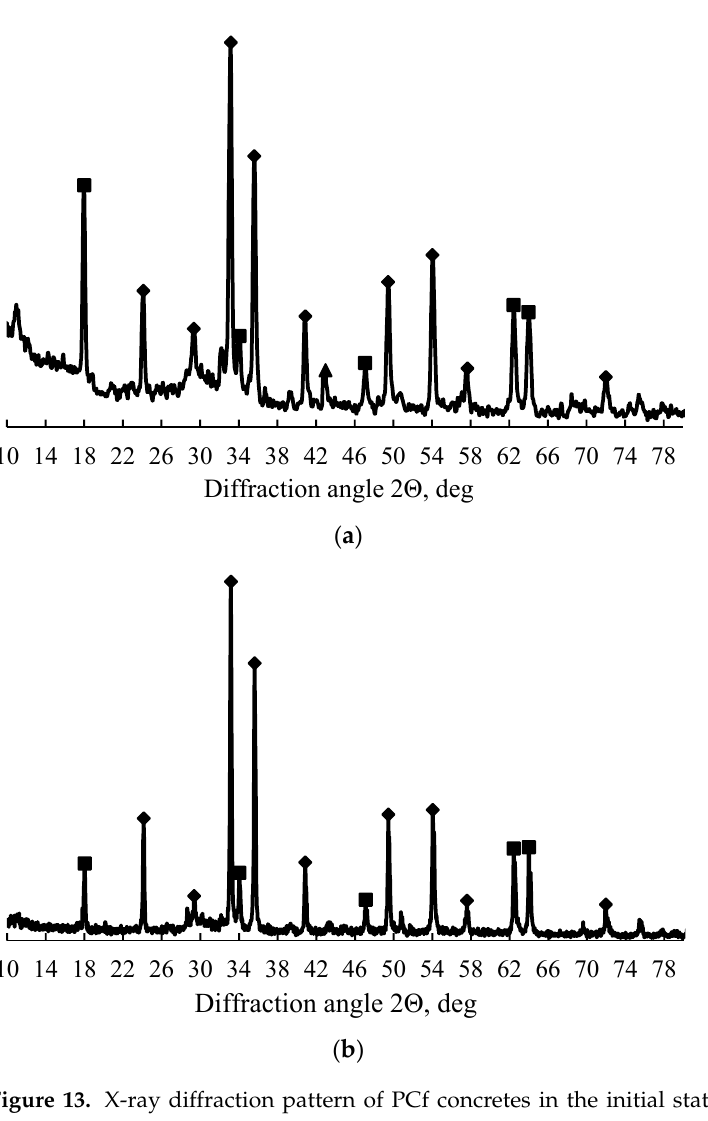
Figure 13. X-ray di ff raction pa tt ern of PCf concretes in the initial state ( a ) and after irradiation ( b ): Figure 13. X-ray diffraction pattern of PCf concretes in the initial state ( a ) and after irradiation ■ = Ca(OH) 2 (000-04-0733); ♦ = Fe 2 O 3 (PDF card 000-33-0664); ▲ = Ca 2 SiO 4 (PDF card 000-14-0693). ( b ): (cid:4) = Ca(OH) 2 (000-04-0733); (cid:7) = Fe 2 O 3 (PDF card 000-33-0664); (cid:78) = Ca 2 SiO 4 (PDF card